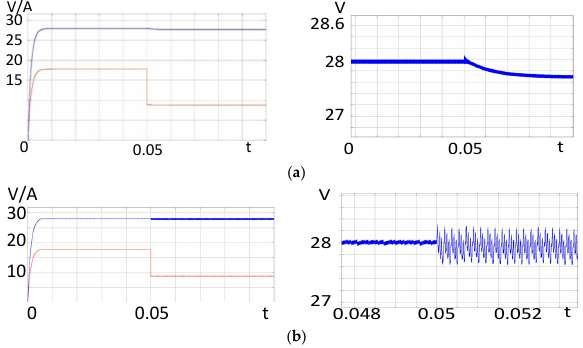
Figure 7. Output waveform and its amplification. ( a ) Optimal control mode; ( b ) Traditional control mode.